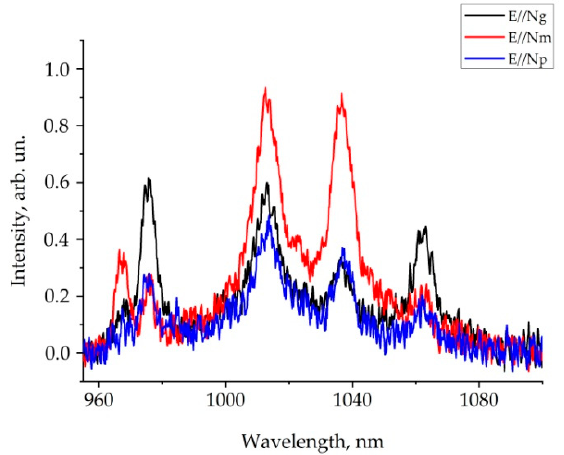
Figure 9. The luminescence spectrum of the Yb:YMBO crystal.